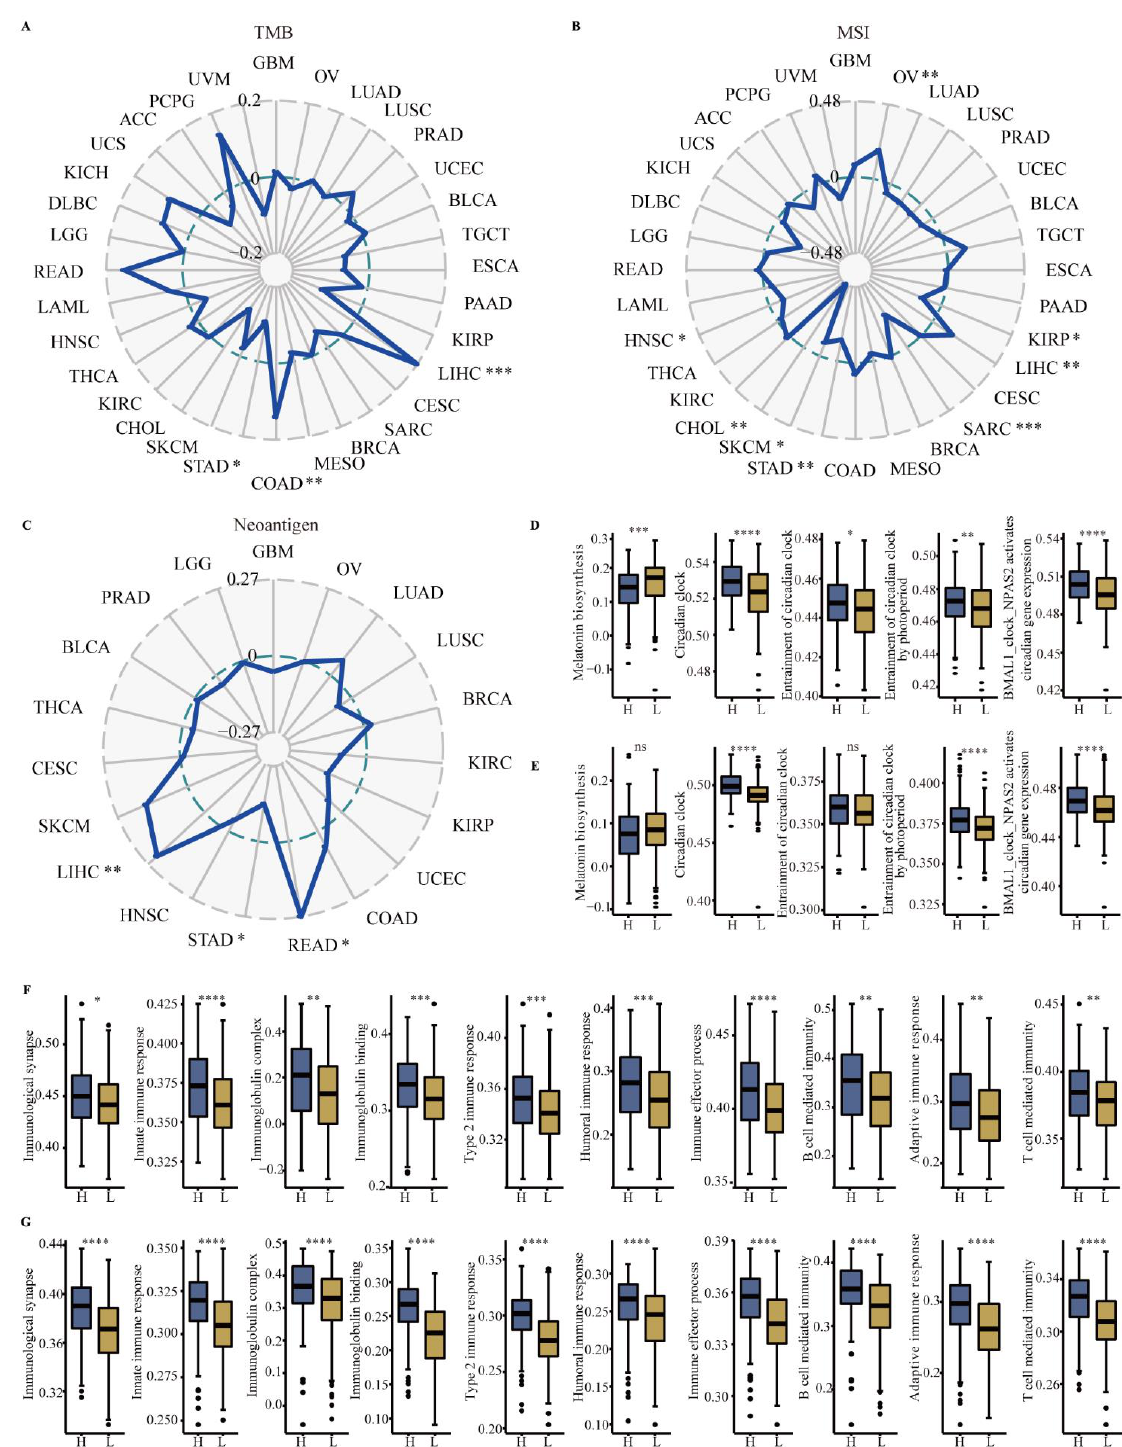
Figure 4. The correlations between CYP1B1 expression and TMB, MSI, neoantigen, and immune- related pathways. ( A ) Correlations between CYP1B1 expression and TMB in cancer. ( B ) Correlation between CYP1B1 and MSI in cancer. ( C ) Correlation between CYP1B1 and neoantigen in cancer. ( D , E ) The melatonin-related pathways enriched by ssGSEA analysis in LIHC ( D ) and STAD ( E ). ( F , G ) The classical immune related pathways enriched by ssGSEA analysis in LIHC ( F ) and STAD ( G ). Two groups (High-expression and Low-expression) of pathway scores with boxplots using the Mann-Whitney U test. * p < 0.05; ** p < 0.01; *** p < 0.001; **** p <